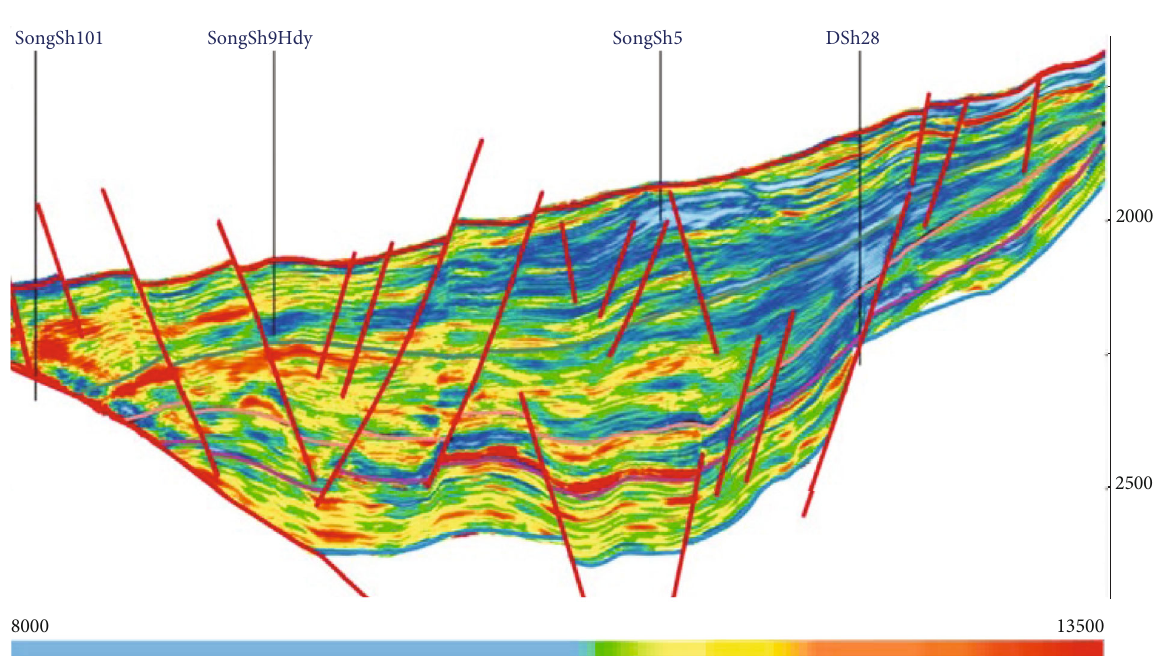
Figure 5: Comparison of P-wave impedance pro fi les of relative impedance (upper) and facies controlled prestack inversion